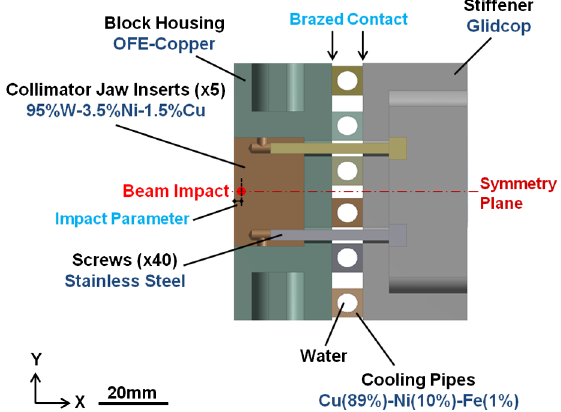
FIG. 2. Detailed cross-sectional view of the x-y plane of a horizontal TCT right jaw assembly. The blue labeling gives the material of each respective component while the red dot indicates the location of the beam impact with a certain impact parameter in case of an accident scenario.